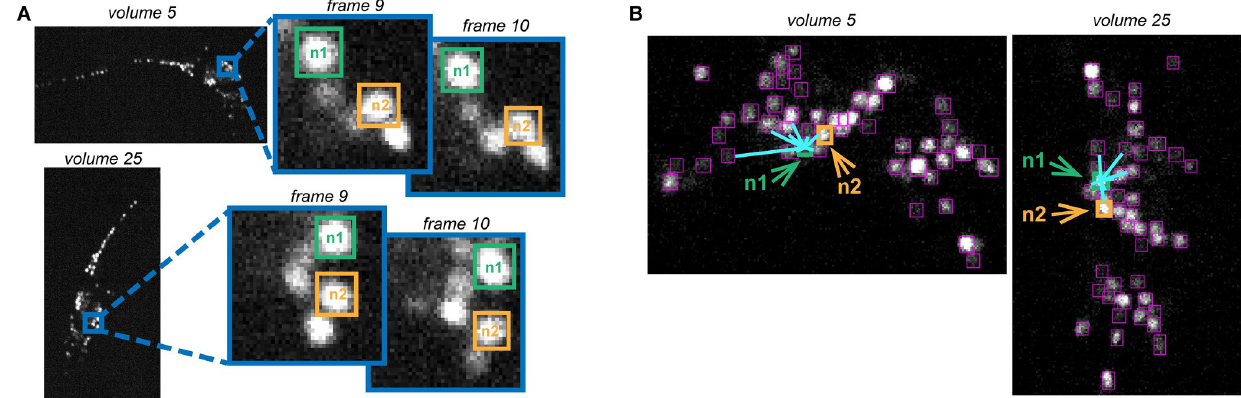
Fig 5. A neuron’s relative position is a more discriminable feature than its shape and texture. (A) The shape or texture of a neuron in an imaging volume is not a distinct feature, which varies significantly across volumes. (B) The position of a neuron relative to its neighboring partners is a more robust and discriminable feature. For example, neuron n 1 and n 2 display similar relative positions in volumes 5 and